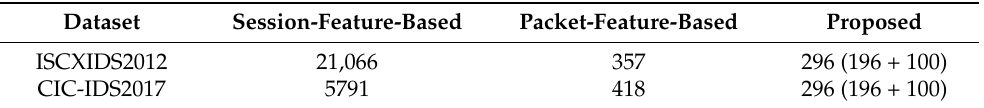
Table 8. Average memory size in bytes for storing the packet data needed to create the feature. Assume that only initial six packets are used for each session and only 100 bytes of each packet are used to create packet-based features.